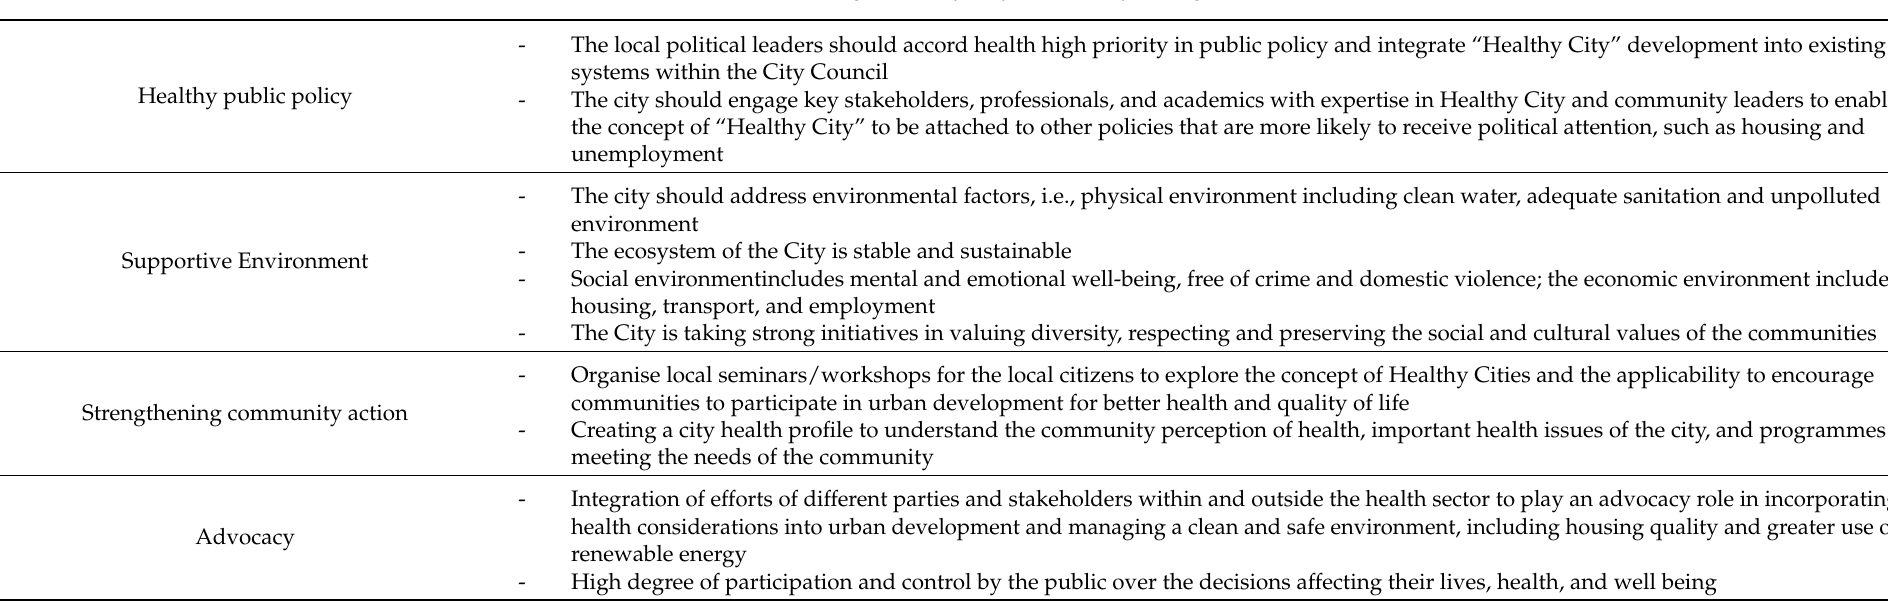
Table 1. Building a Healthy City for Healthy